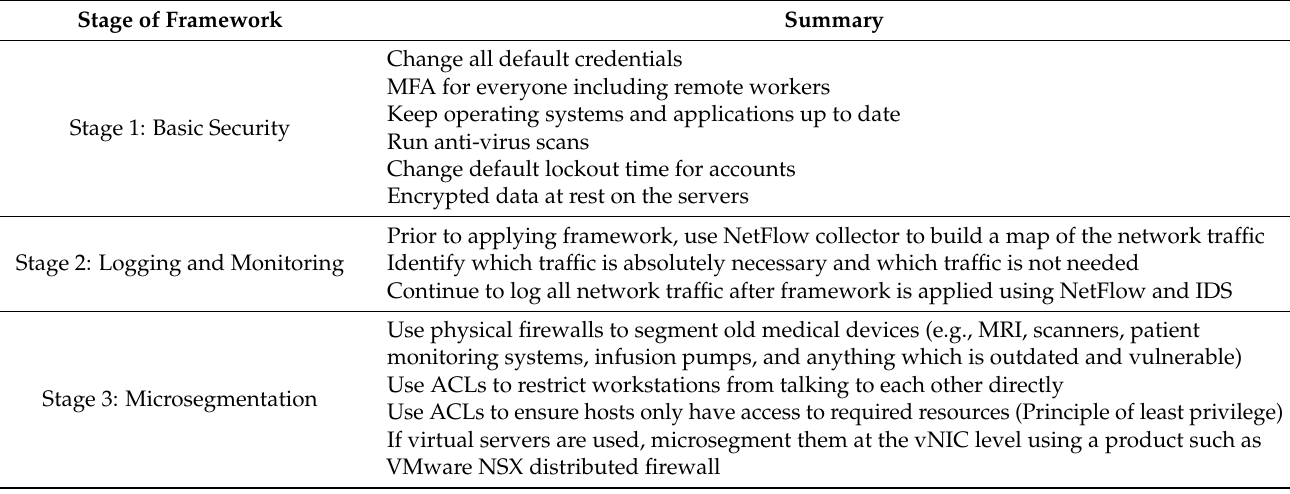
Figure 5. Summary of the framework to support healthcare organisations in transitioning to a zero-trust-inspired network architecture with an example network topology. Table 2. Summary of the stages of the framework from basic security to defence in depth. Stage of Framework